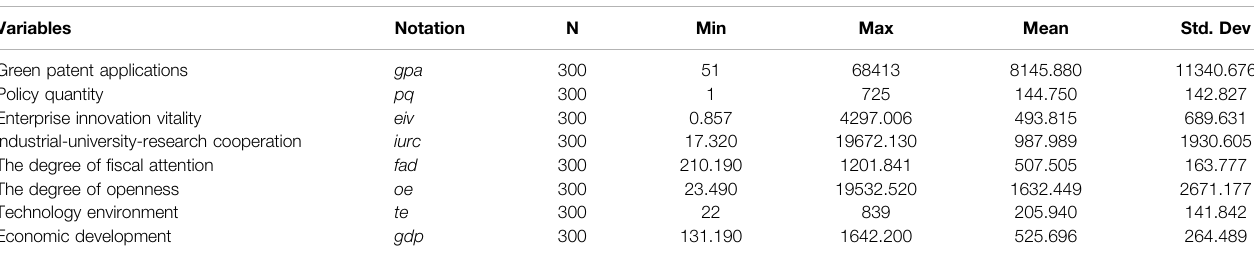
TABLE 3 | Descriptive